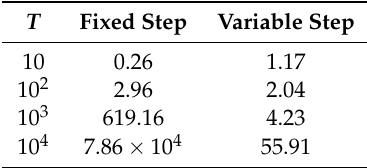
Table 3. Comparison of the CPU-time in our approach, for different values of T and for T / N = 1/100, λ = −